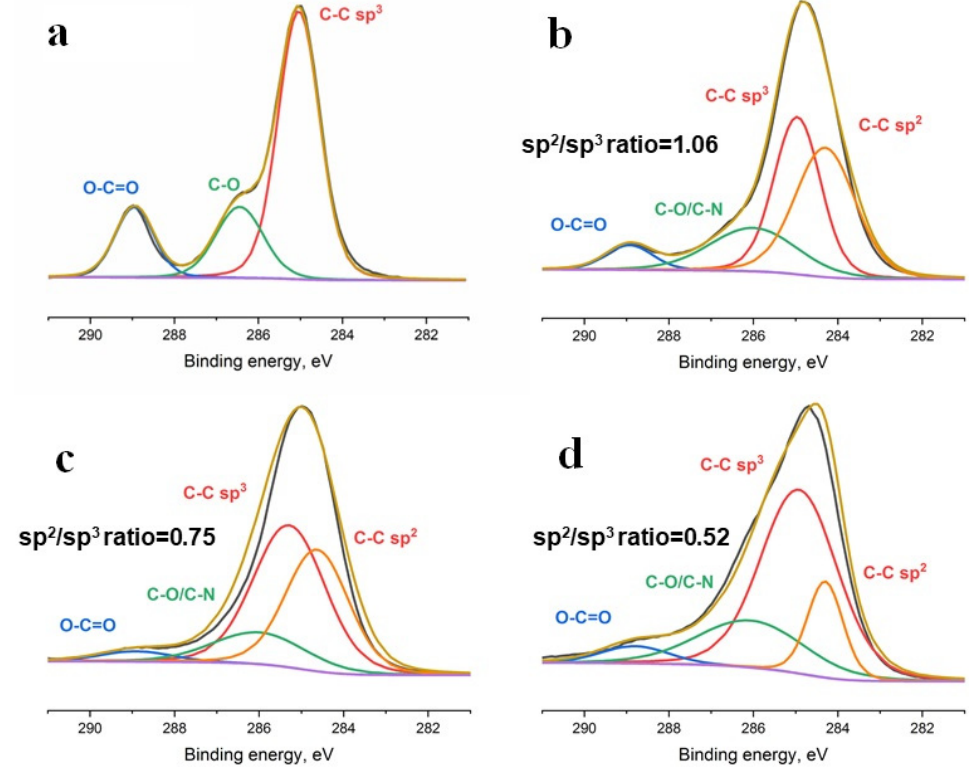
Figure 4. C1s spectra of the control and modified scaffolds. ( a )—spectrum of the control sample, ( b – d )—spectra of the samples coated under 5 × 10 − 3 , 5 × 10 − 2 and 5 × 10 − 1 Pa nitrogen pressure, respectively.